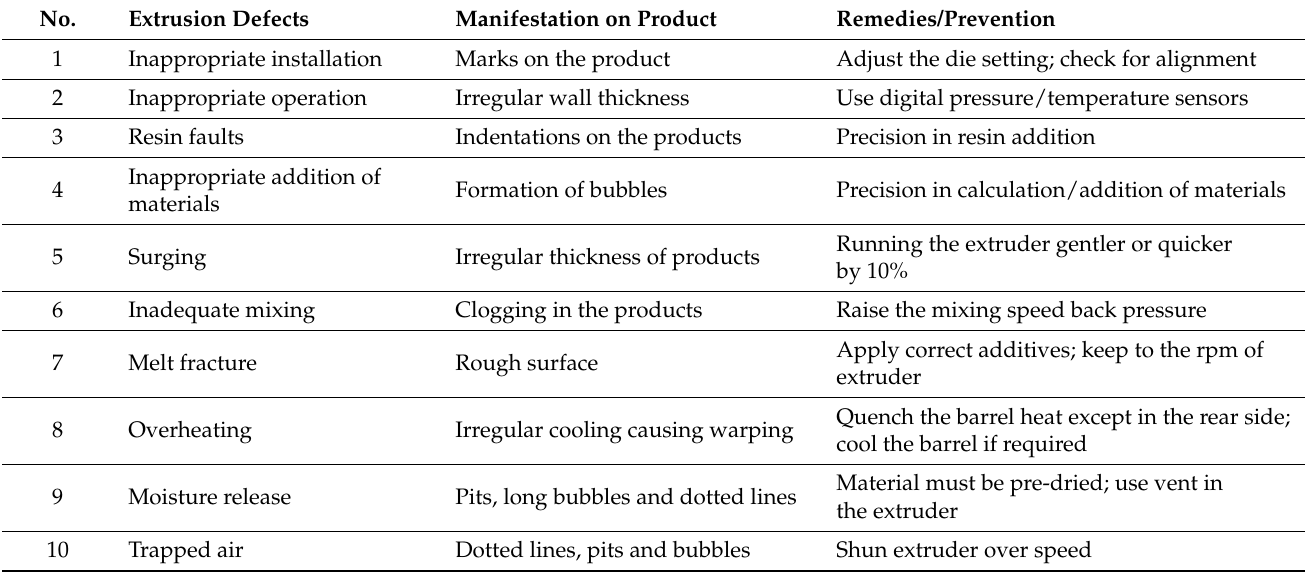
Table 2. Defects Common with Extrusion Technique